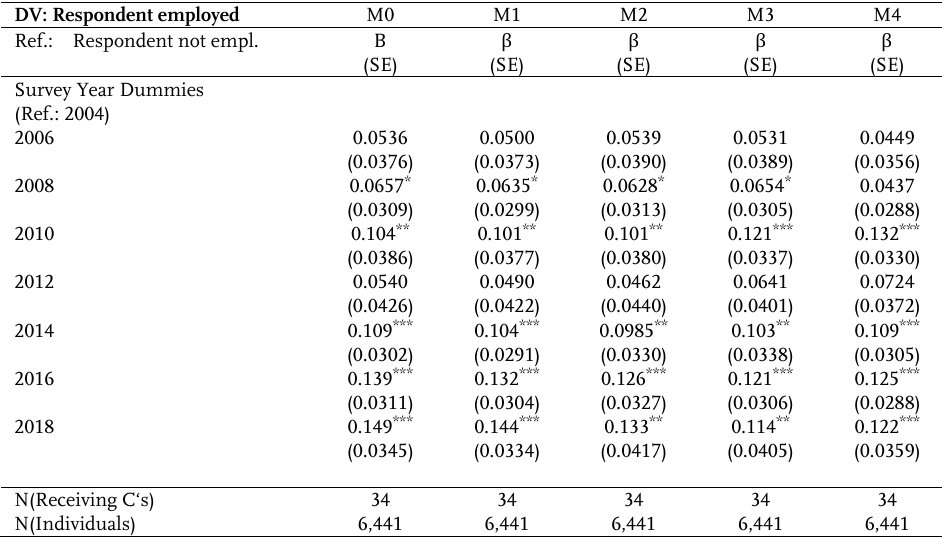
Effects of discrete time trends for models M0 to